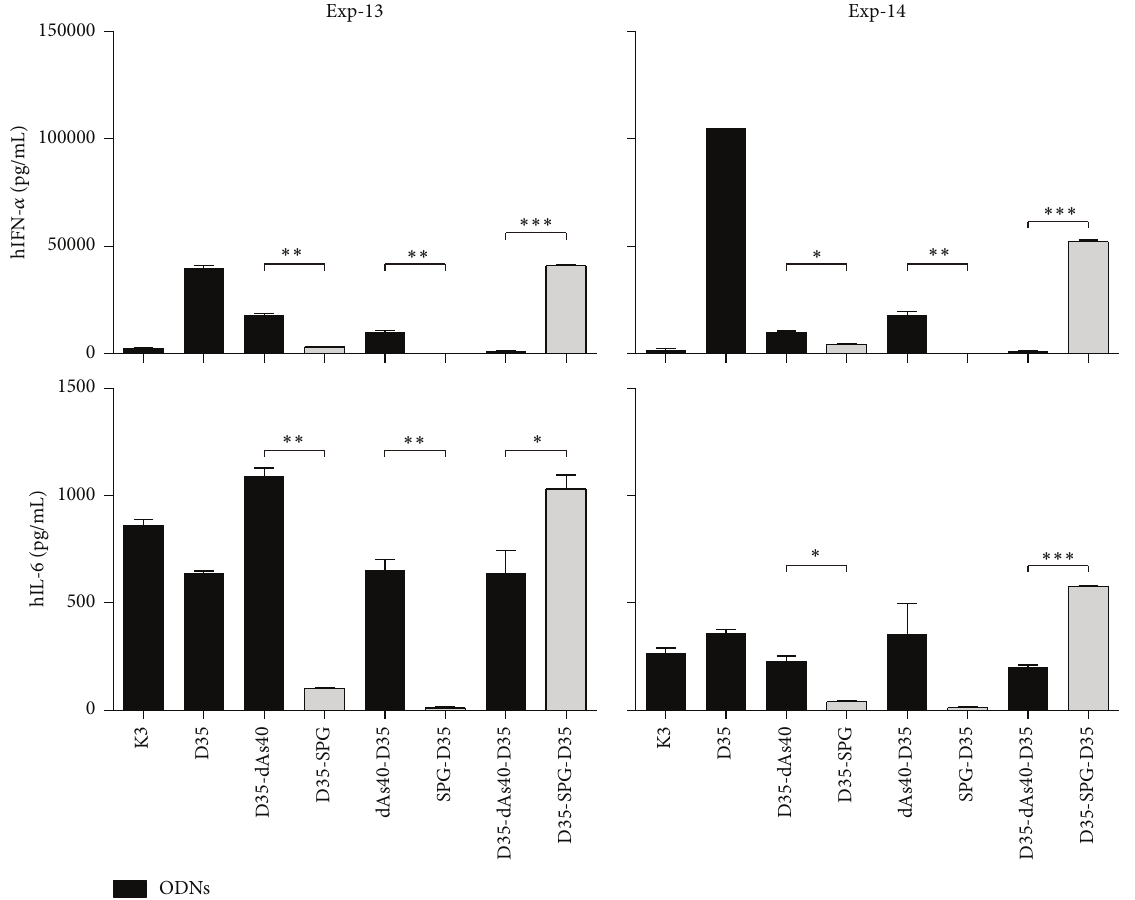
Figure 10: D35 modification with dAs40 at 5 󸀠 and/or 3 󸀠 ends and their SPGylation effect on cytokine production from human PBMC. Human PBMCs were stimulated with ODNs (D35-dAs40, dAs40-D35, and D35-dAs40-D35; 1 𝜇 M each) or their SPGylated ODNs (D35-SPG, SPG- D35, and D35-SPG-D35; 1 𝜇 M each ODN amount), and then 24 hours later, IFN- 𝛼 and IL-6 secretion in supernatants were determined by ELISA. Bar graph shows mean ± SEM in triplicate. ∗ 𝑃 < 0.05 , ∗∗ 𝑃 < 0.01 , and ∗∗∗ 𝑃 < 0.001